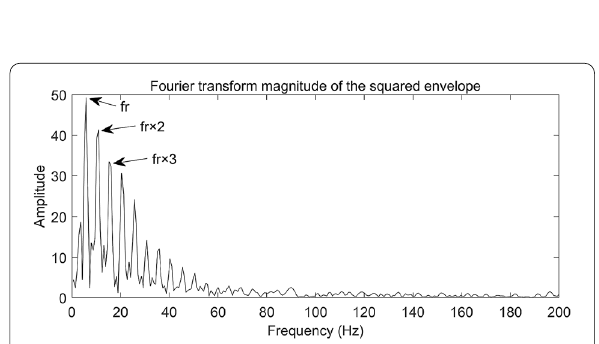
Figure 6 The squared envelope spectrum of the processed signal is based on the proposed